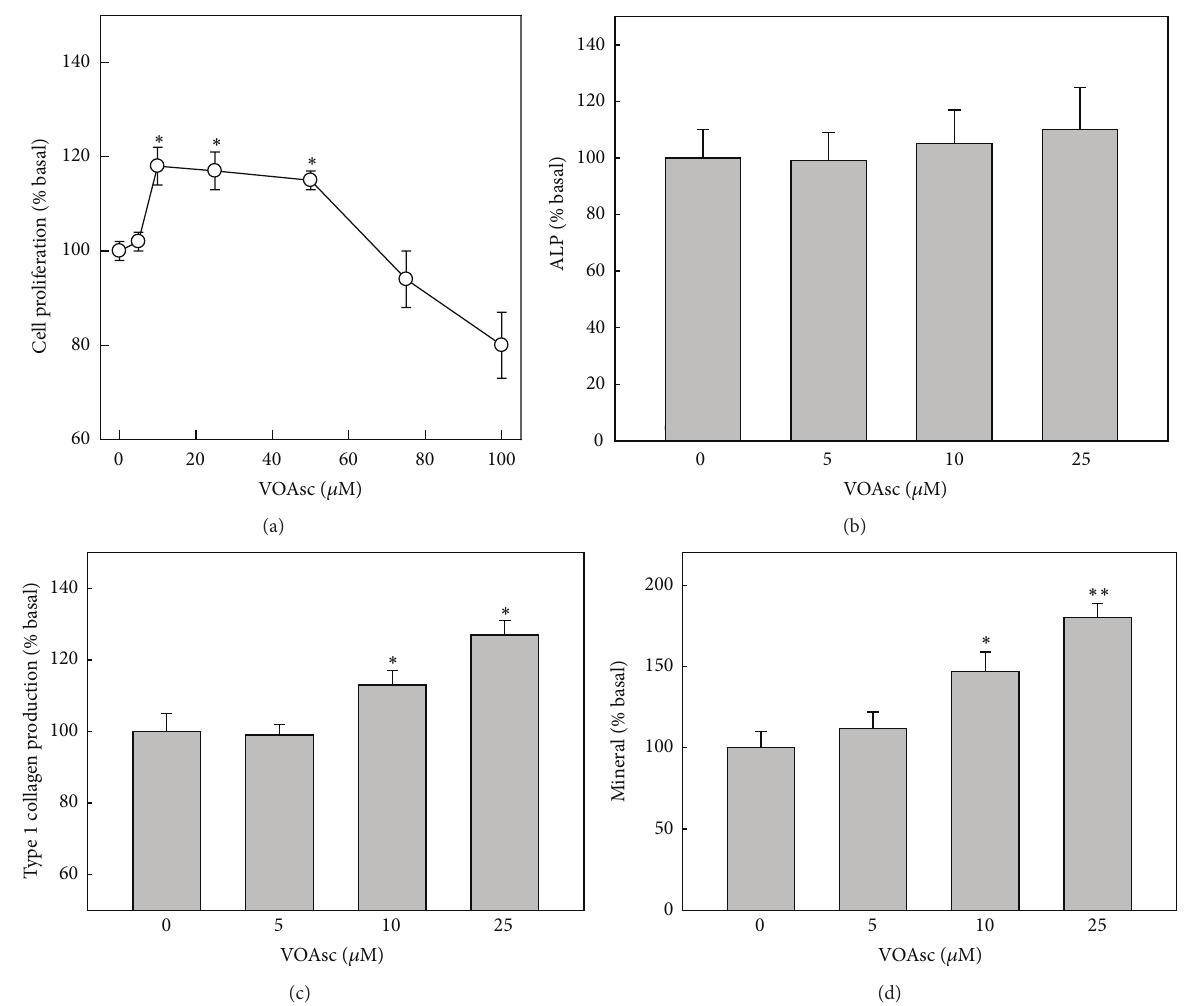
Figure 4: Effect of VOAsc on cell proliferation, differentiation, and mineralization. BMPC were incubated with different doses of VOAsc. Cell proliferation was determined after 24 h of culture (a) and osteoblastic differentiation was assessed by ALP (b), type 1 collagen production (c) and matrix mineralization by calcium nodules deposition (d) after 2 weeks of culture in an osteogenic media in the presence of different concetrations of VOAsc. Data represent the mean ± SEM of three independent experiments and are expressed as % basal. ∗ 𝑝 < 0.05 , ∗∗ 𝑝 < 0.01